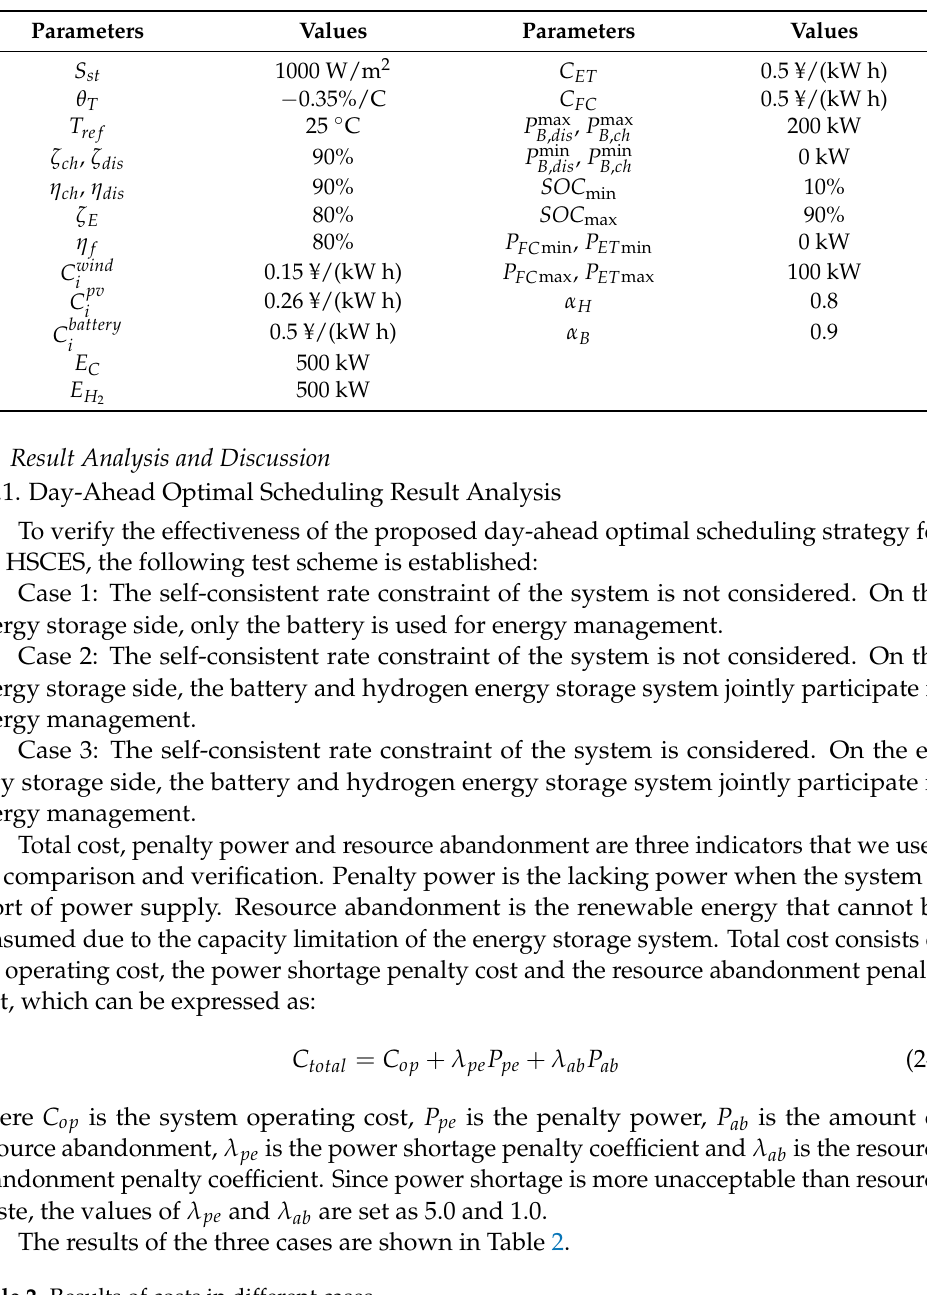
Table 1. System parameters.